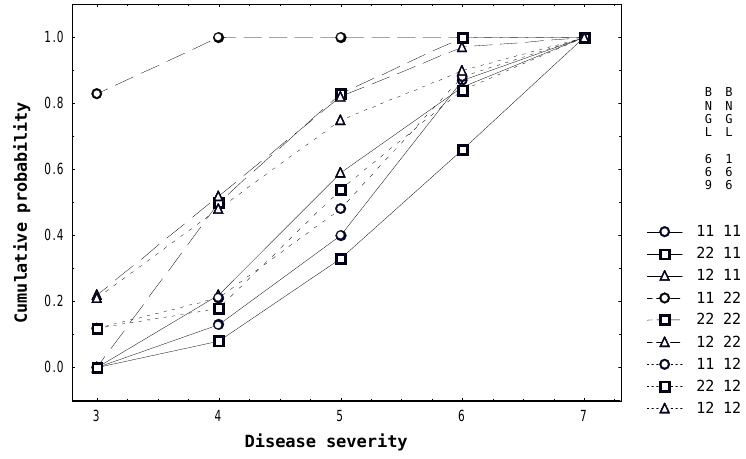
Figure 1 - Cumulative probabilities at the jth